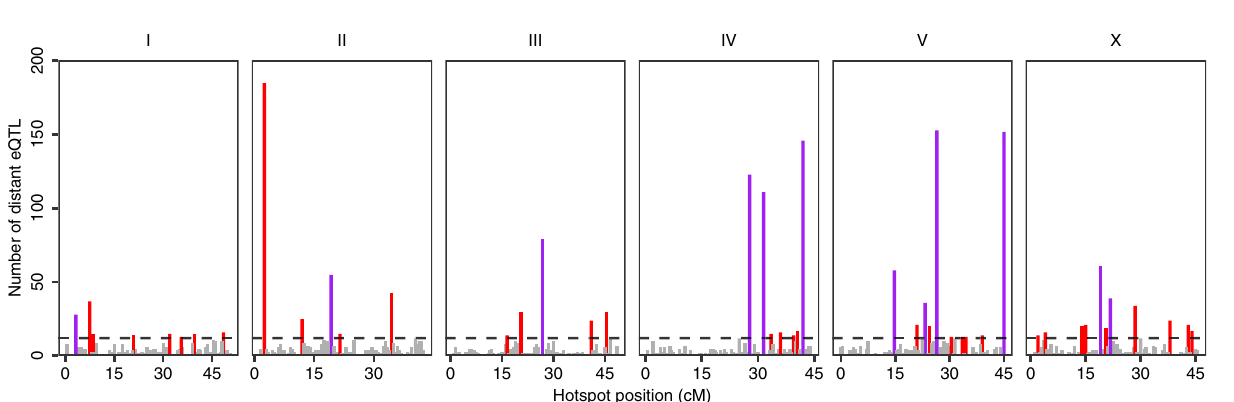
Fig. 3 Distant eQTL hotspots. The number of distant eQTL ( y -axis) in each 0.5 cM bin across the genome ( x -axis) is shown. The horizontal dashed line indicates the threshold of 12 eQTL. Bins with 12 or more eQTL were identi fi ed as hotspots and are colored red. Adjacent bins that all passed the threshold were merged and are colored purple, with the center of the merged bins as the position on the x -axis. Bins with fewer than 12 eQTL are colored